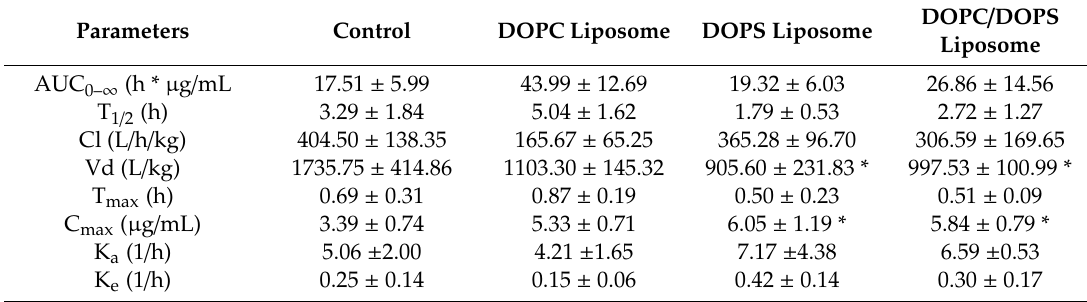
Table 3. Comparative in vivo pharmacokinetic parameters of free drug and belinostat-loaded liposomal formulations.